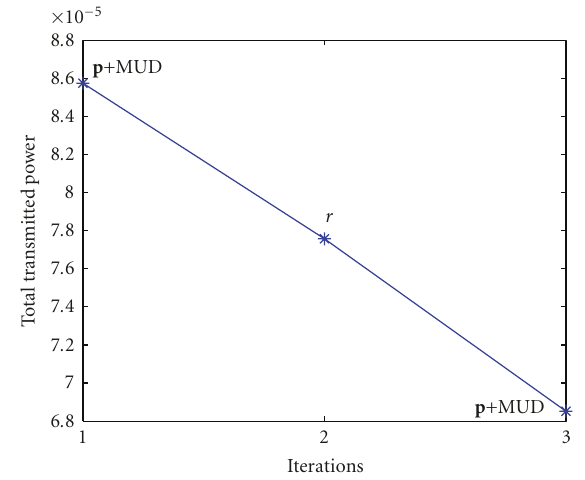
Figure 11: Total transmission power: joint power control, mul- tiuser detection, and routing.